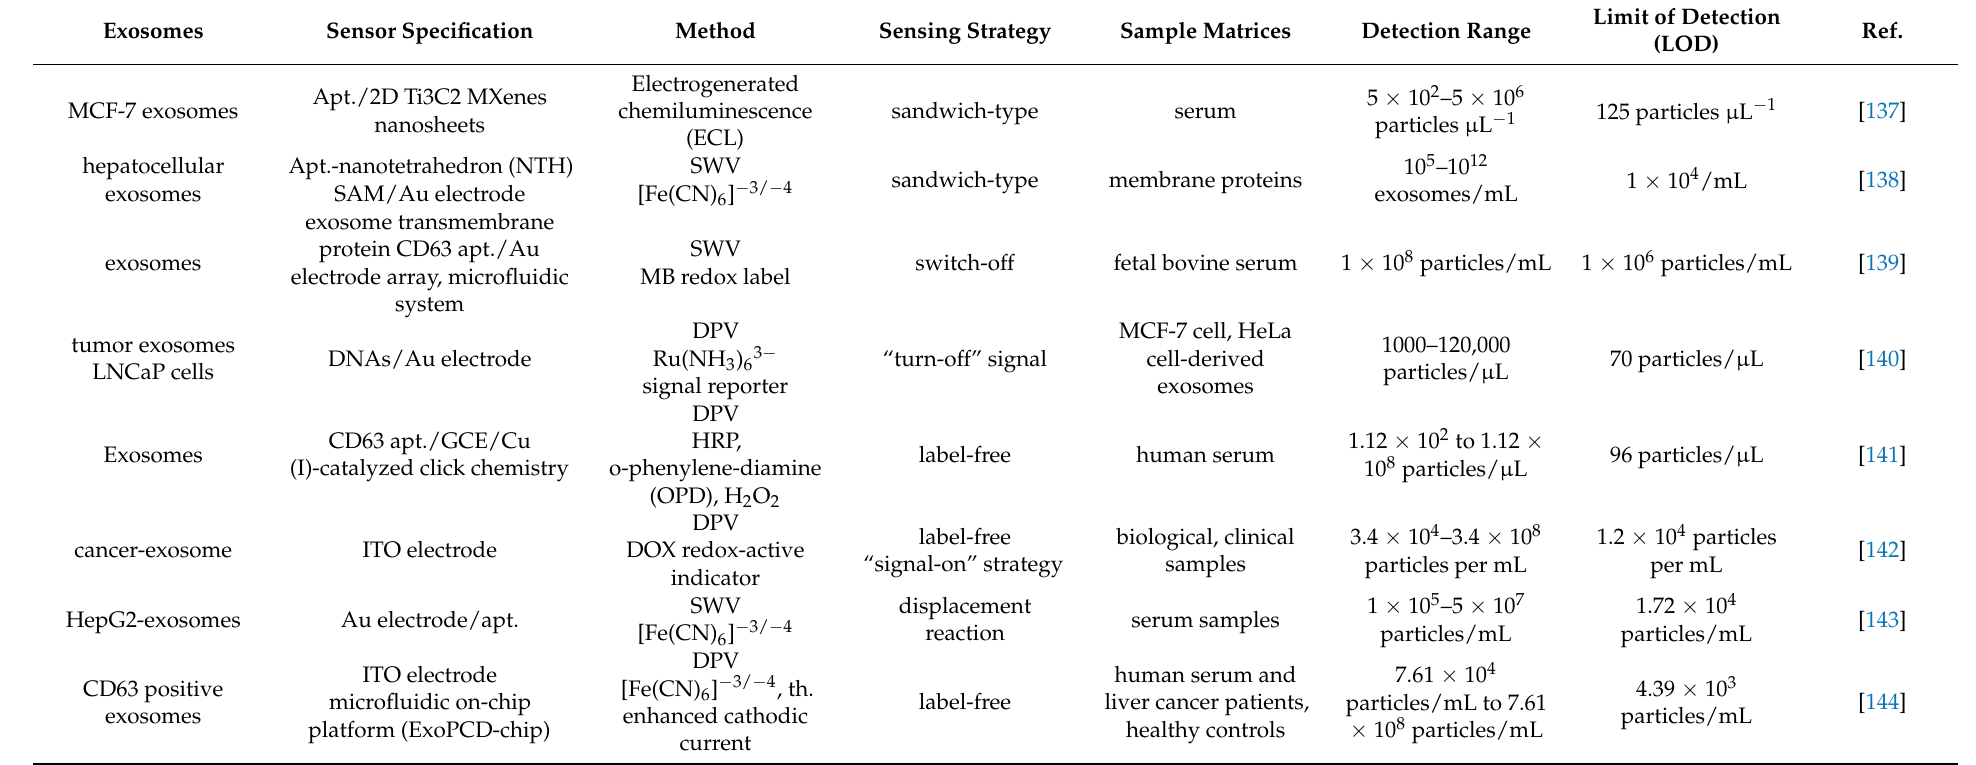
Table 6. Specifications and electrochemical performance of aptasensors for